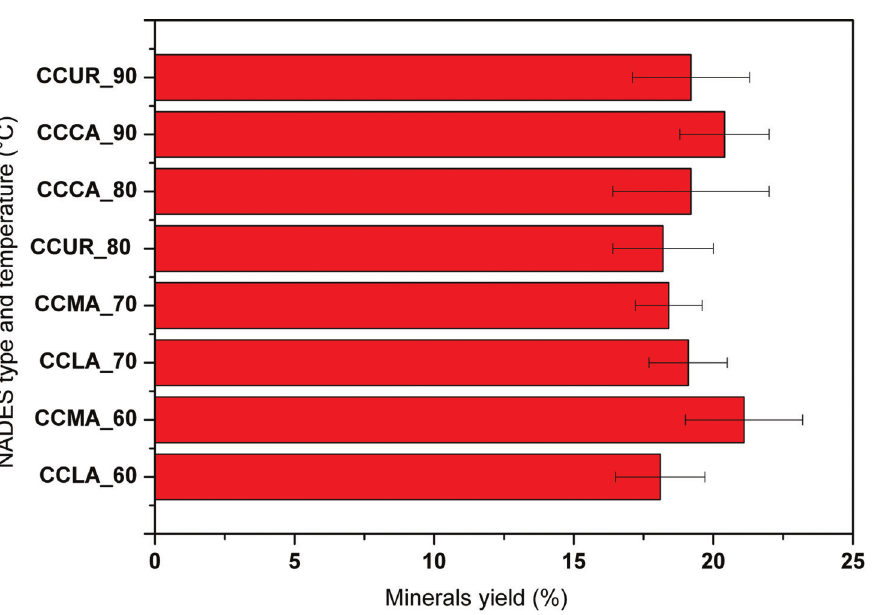
Figure 4: Mineral yield after precipitation with NaOH for the different NADES under study.